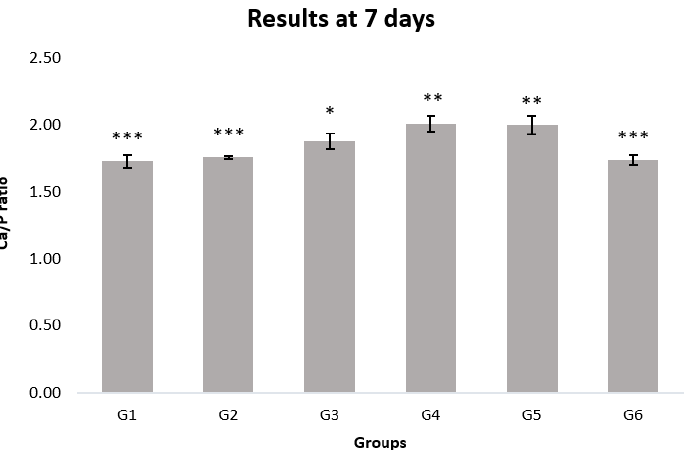
Figure 8. Ca/P ratio of all groups determined using EDS. One-way ANOVA with Tukey’s multiple comparison test; p < 0.05 is significant. Results are reported as average value and standard deviation. The following levels of statistical significance were considered: p < 0.05 *, p < 0.01 **, p < 0.001 ***. G1 (Mousse Group), G2 (Nano-Hydroxyapatite Group), G3 (Duraphat Group), G4 (Biosmalto Group), G5 (group treated with the demineralizing solution), G6 (group without any treatment).